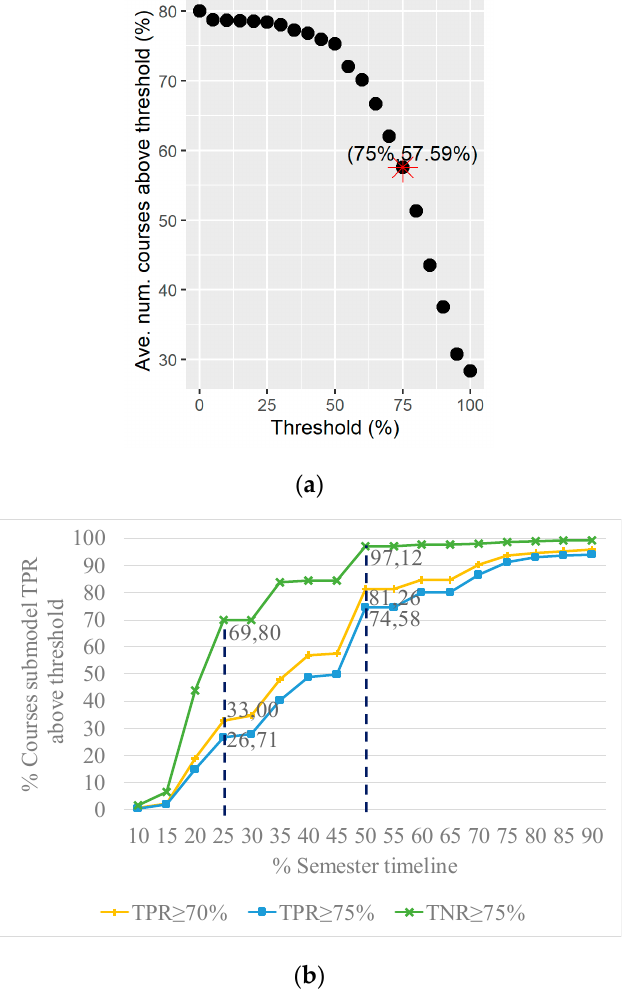
Figure 4. ( a ) Pareto Points distribution of f(x) summands and optimal value. ( b ) Percentage of courses where the GAR model can be applied with high-quality based on different thresholds for TNR and TPR.